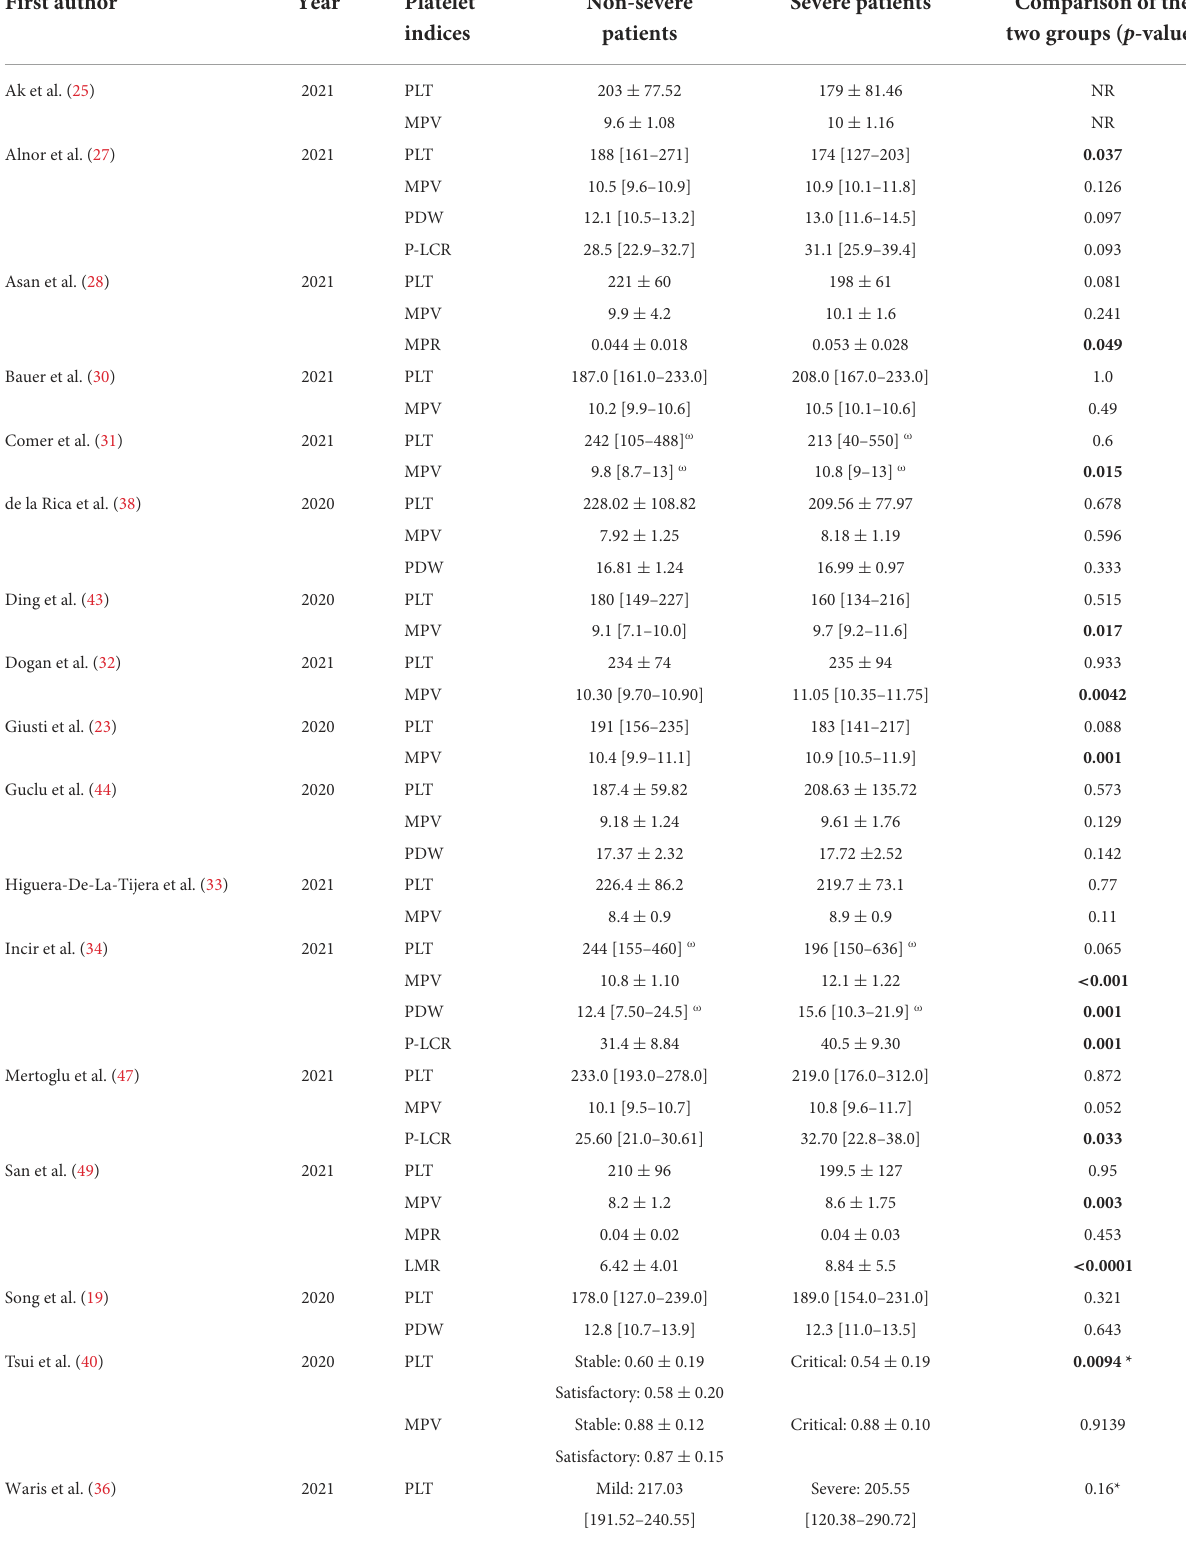
TABLE 2 Values of platelet indices in the COVID-19 patient severe and non-severe groups at